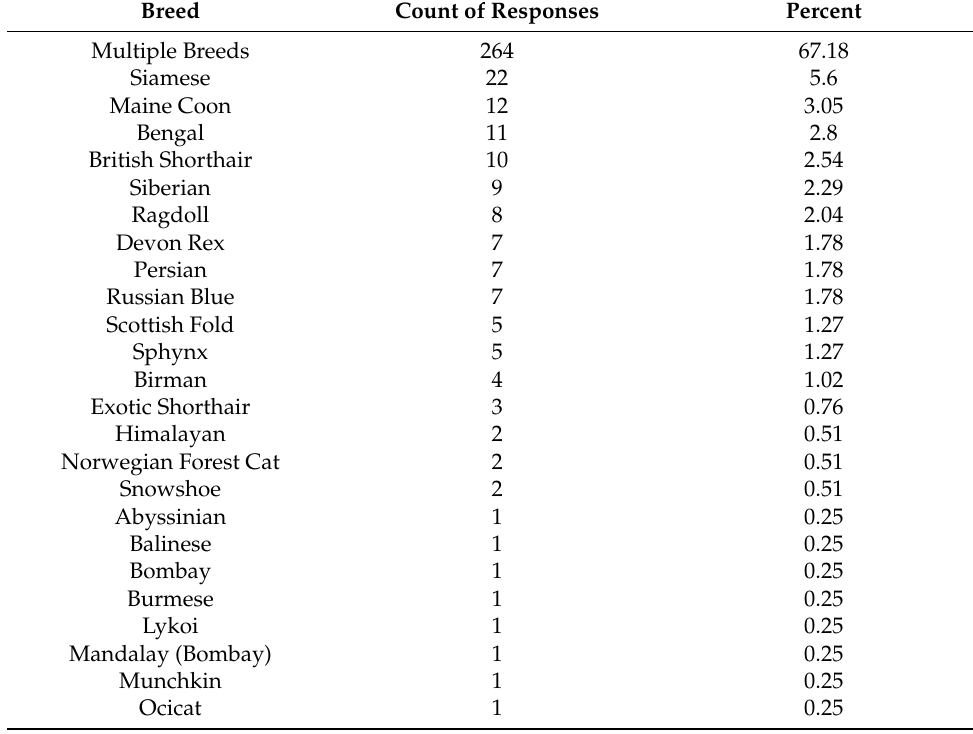
Table 2. Breed reported for cats treated with